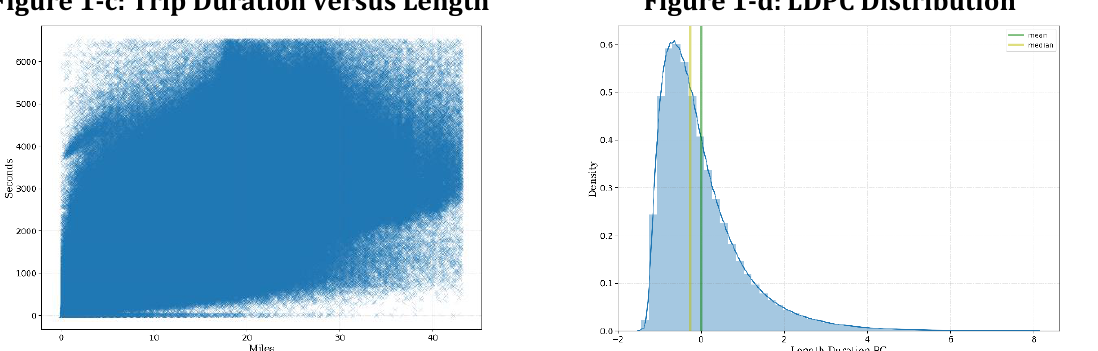
Figure 1-c: Trip Duration versus Length Figure 1-d: LDPC